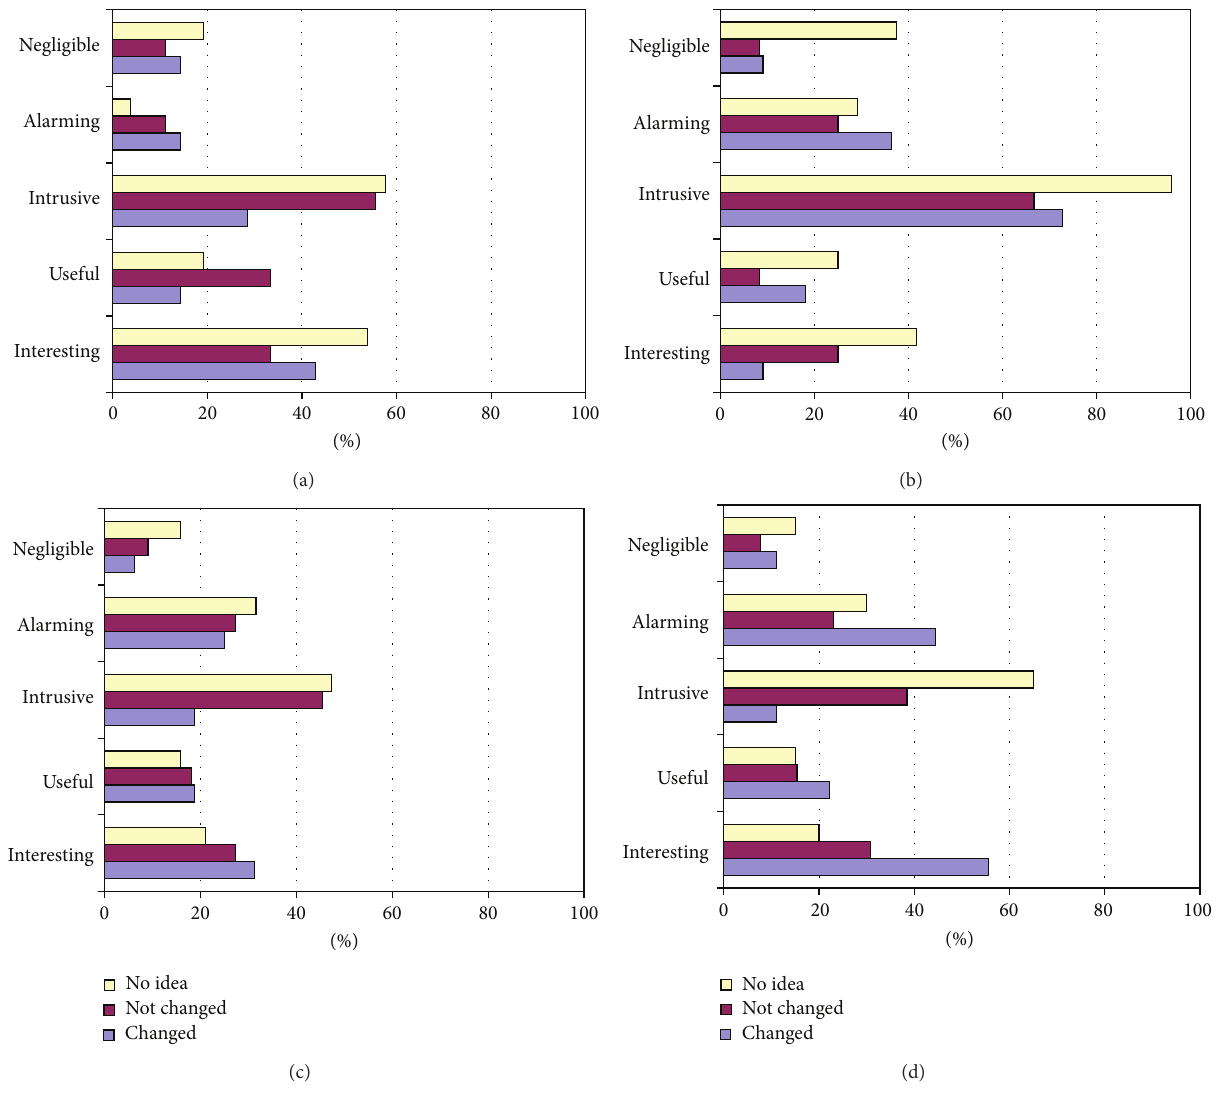
Figure 23: Definition given according to privacy settings changes: (a) DN men; (b) DN women; (c) DI men; (d) DI